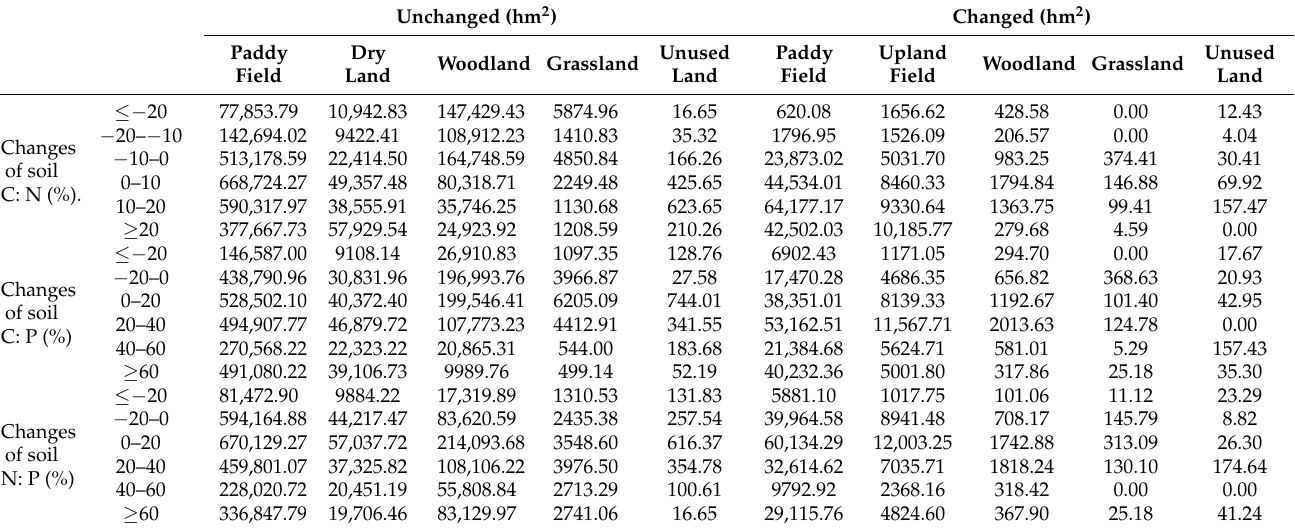
Table 1. Alteration of soil C:N, C:P, and N:P coupled with agricultural land use types changes between 1980 and